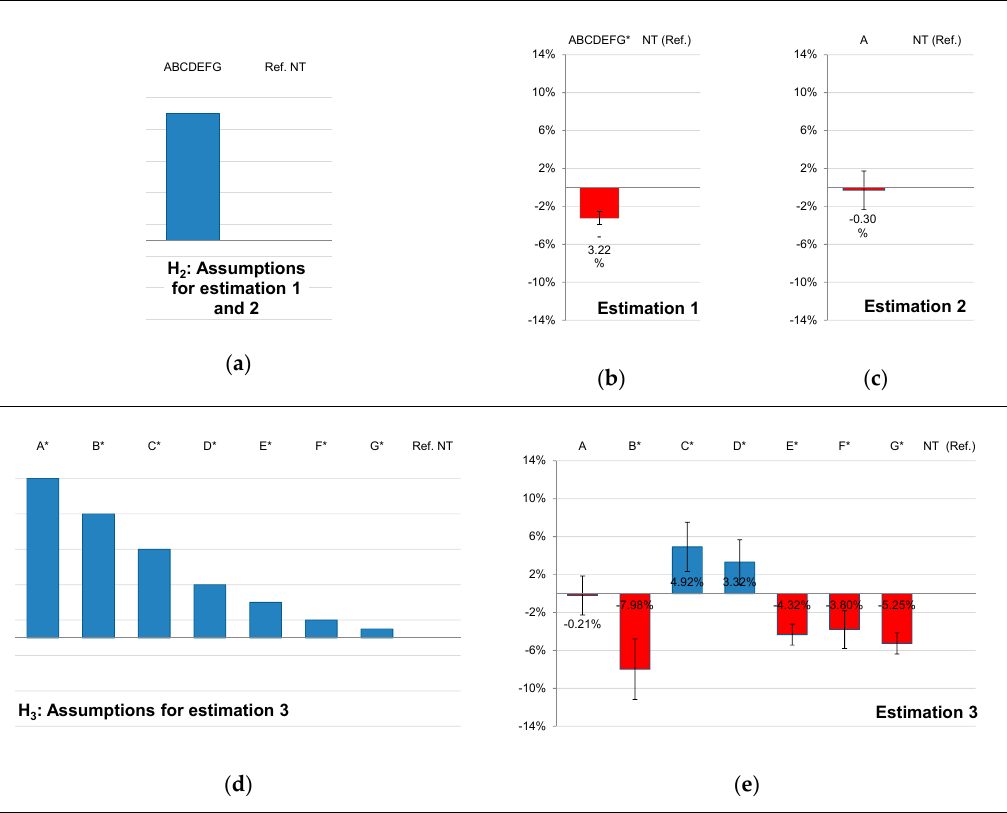
Figure 9. Bar graph with the asking price premiums (%) and CI (95%) for estimations 1 to 3 of the model. ( a ) Assumptions for estimations 1 and 2; ( b ) estimation 1; ( c ) estimation 2; ( d ) Assumptions for estimation 3; ( e ) estimation 3. Note: * statistically significant result.